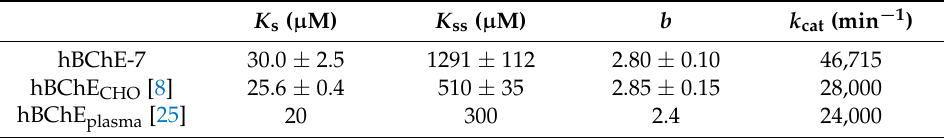
Table 3. Comparison of the determined enzymatic parameters of the hBChE-7 mutant. K s is the dissociation constant at the catalytic site, K ss is the dissociation constant at the peripheral non-productive site, b is the factor affecting k cat describing inhibition or activation resulting from the binding of substrate at the peripheral site. Parameters are compared to those reported to hBChE-4SugOff produced in Chinese Hamster Ovary (CHO) cells and human plasma